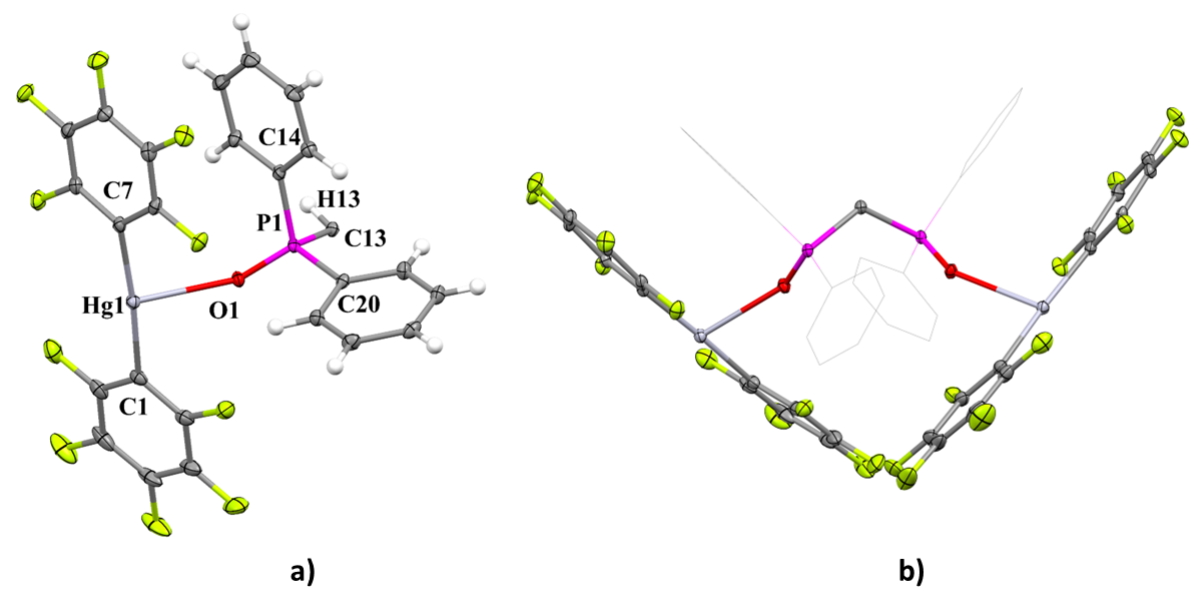
Figure 1. Molecular structure of 1Hg ( a ) asymmetric unit and ( b ) perspective view of the complex. All hydrogen atoms are omitted for clarity. Displacement ellipsoids are drawn at the 30% probability level. Selected bond lengths (Å) and bond angles ( o ): Hg1-O1 2.5373(14), P1-O1 1.4895(15) P1-C13 Table 1. Hydrogen-bond geometry of 1Hg (Å , °).